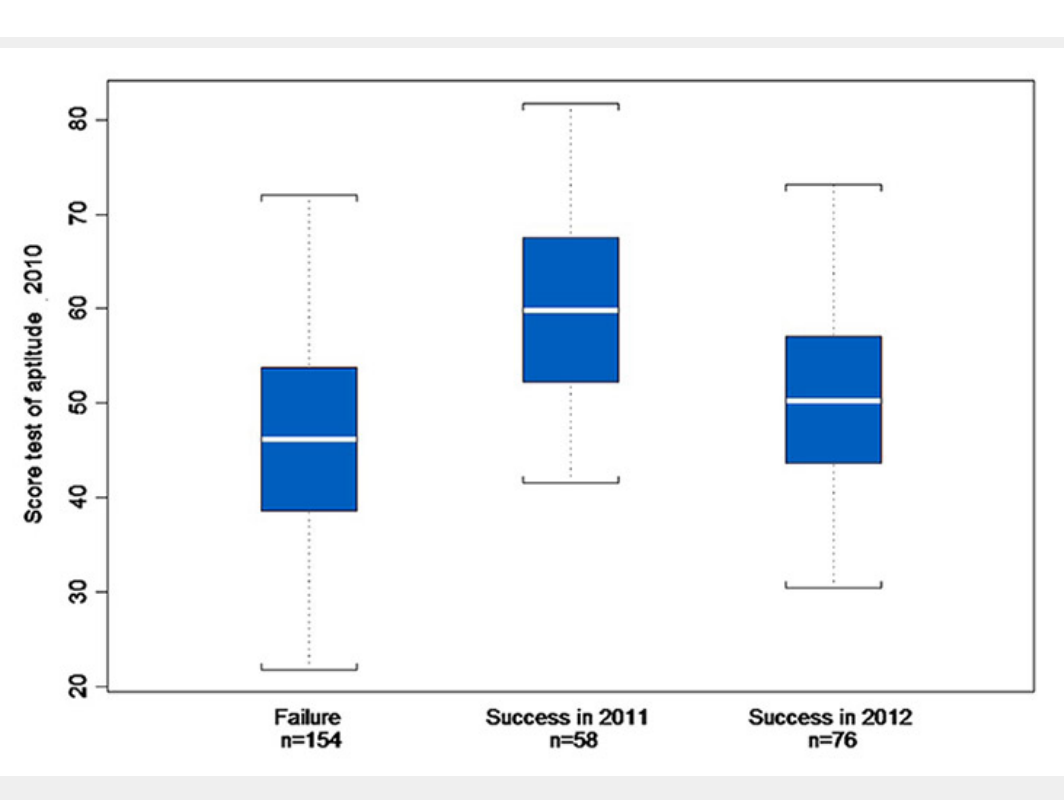
Figure 1 Boxplot of the scores obtained in the aptitude test in 2010 for the students who failed to pass in bachelor year 2 within the time allowed (two academic years), the ones who succeeded immediately (success in 2011) of after repeating year 1 (success in